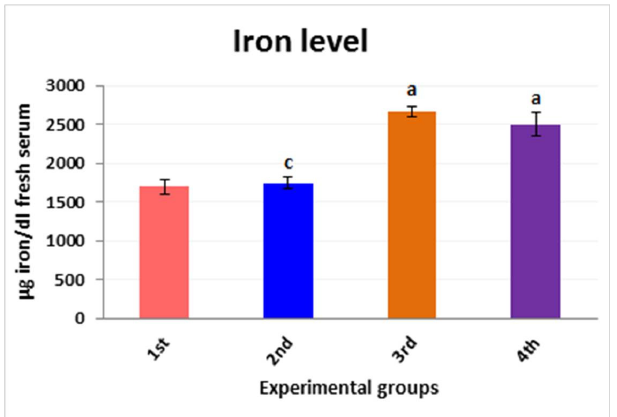
Figure 13. Iron level for mice in the fresh serum of the different experimental groups: the first group is controlled mice (red column), the second group is PPE-treated mice (blue column), the third group is Fe 2 O 3 -NPs-exposed mice (orange column), and the fourth group is Fe 2 O 3 -NPs plus PPE-treated mice (purple column). Values are expressed as mean ± SE; they differ significantly at p < 0.05 by one-way ANOVA followed by Tukey’s multiple comparison post hoc test. The different letters (a, b, c) are different levels of significance ( p < 0.05). The “a” letter indicates high significance, the “b” letter indicates significance, and the “c” letter indicates non-significance.